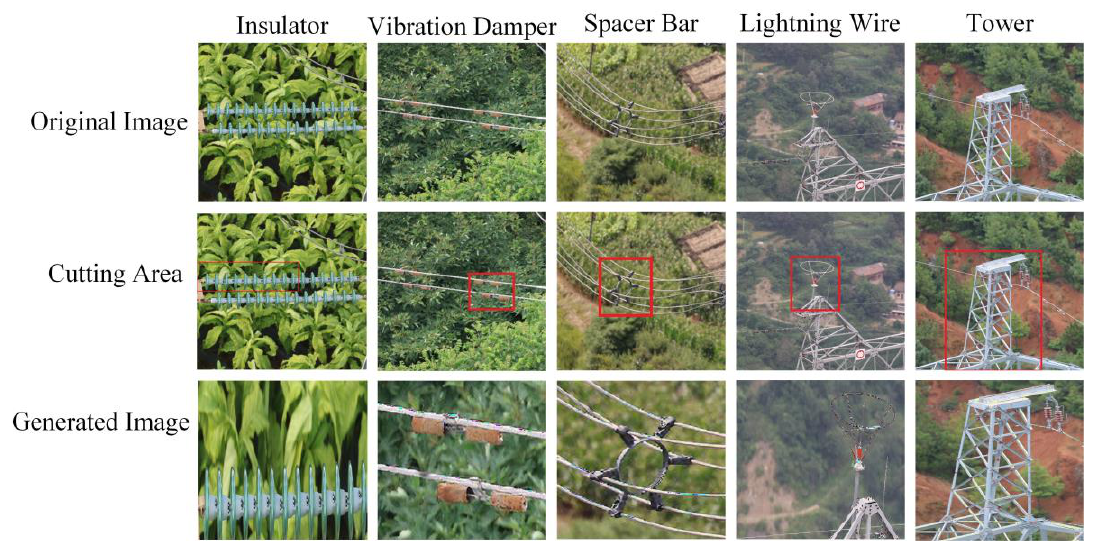
Figure 5. The experimental results of generating images are based on the essential components’ marked images on KCIGD dataset.